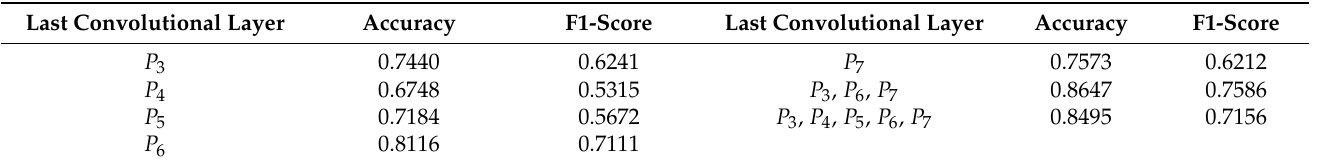
Table 2. Classification results for the networks using P 3 – P 7 as the last convolutional layer. Each of the seven models shown is trained separately for the treatability classification